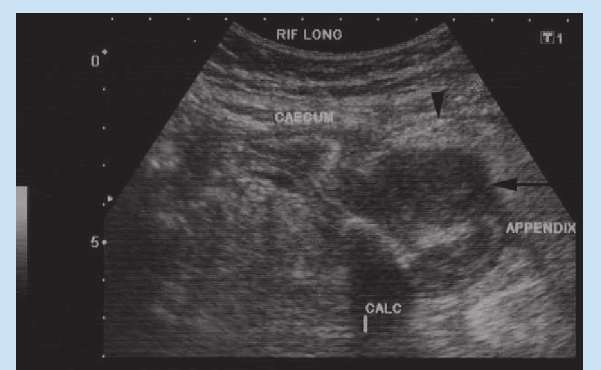
Fig. 3. Ultrasound of the abdomen. Distended appendix containing appendicolith. Adjacent low echogenicity fluid collection (arrow) and echogenic inflamed fat (arrowhead). Although not indicated in the figure, the appendiceal diameter was 12